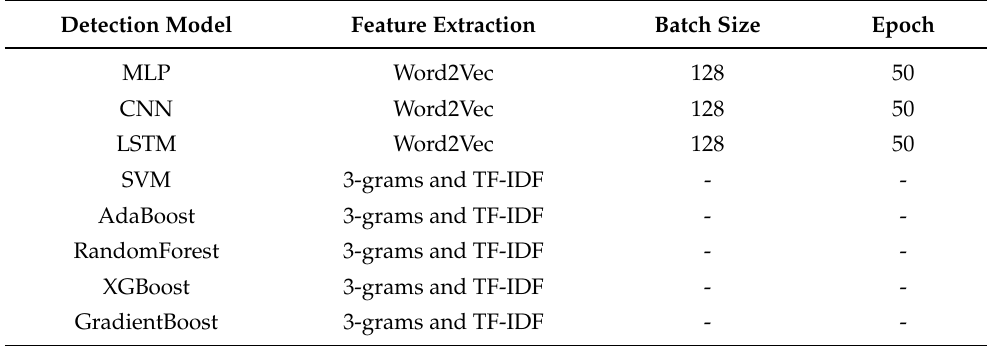
Table 4. The parameters of the detection model. Detection